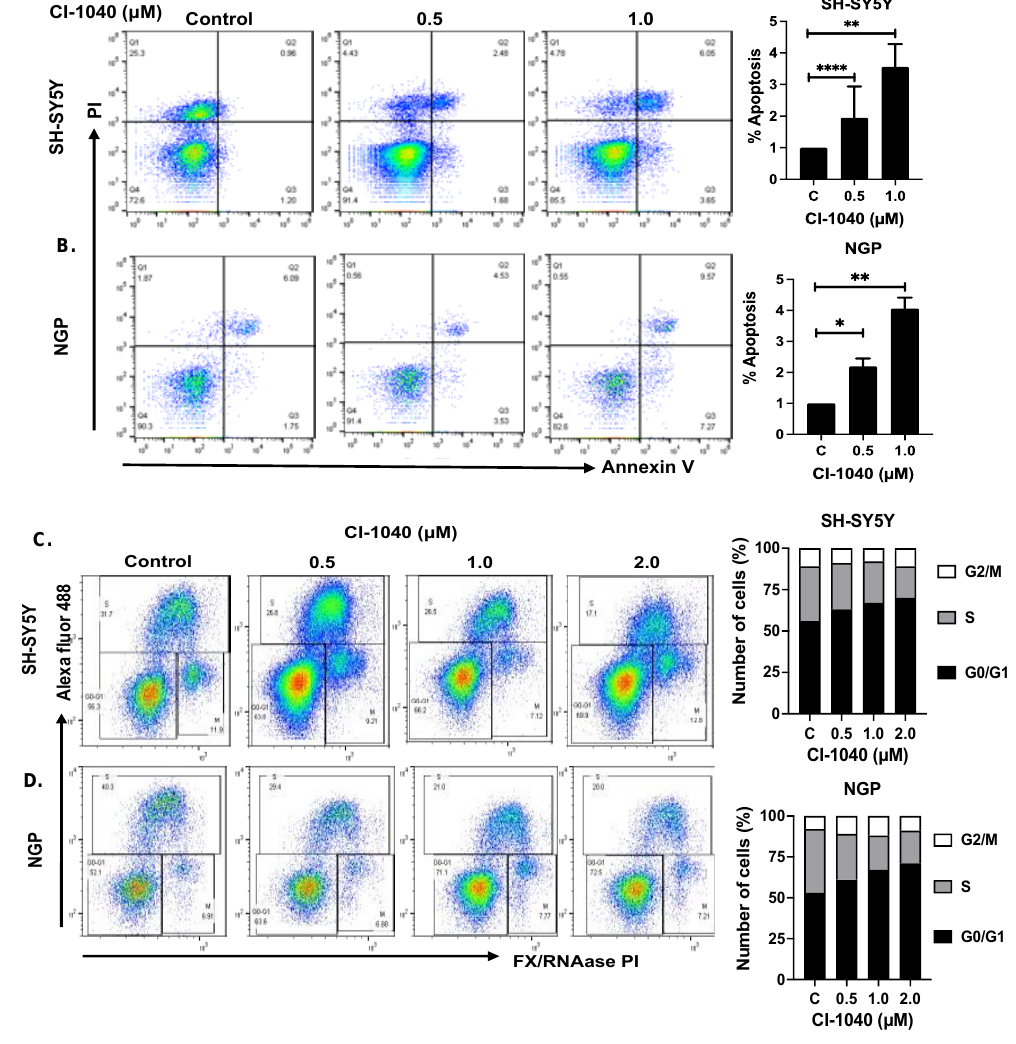
Figure 4. CI-1040 induces apoptosis and blocks cell cycle progression in NB cells. Apoptosis and cell cycle assays were performed using 2 NB cell lines including MYCN amplified (NGP) and MYCN